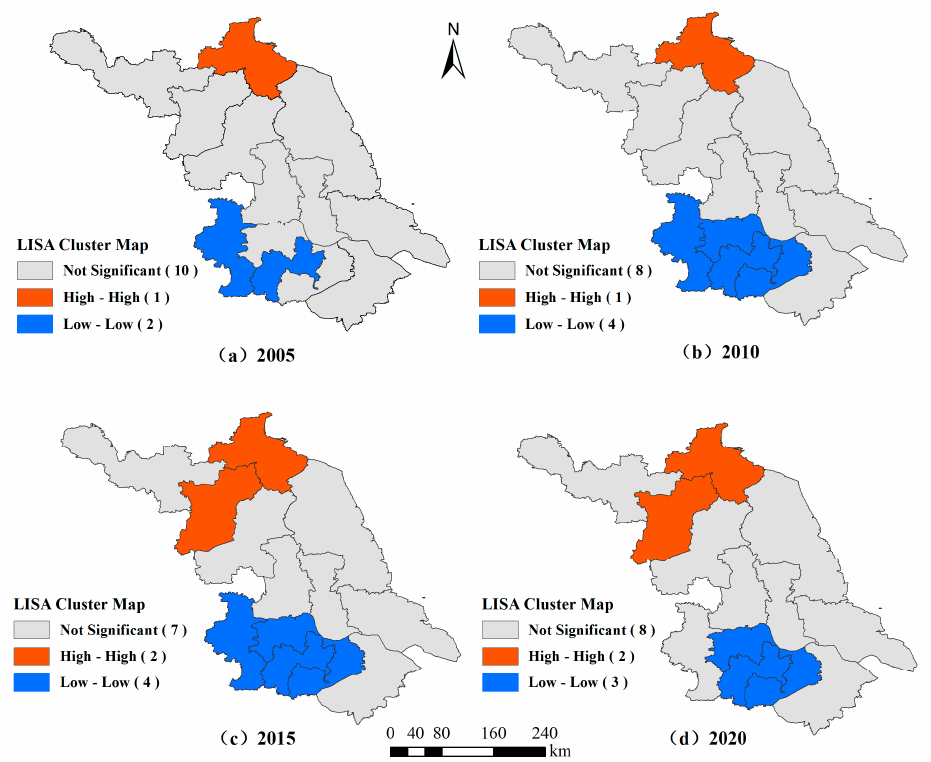
Figure 7. Local spatial autocorrelation LISA aggregation of ACEs in Jiangsu Province in Main Years.